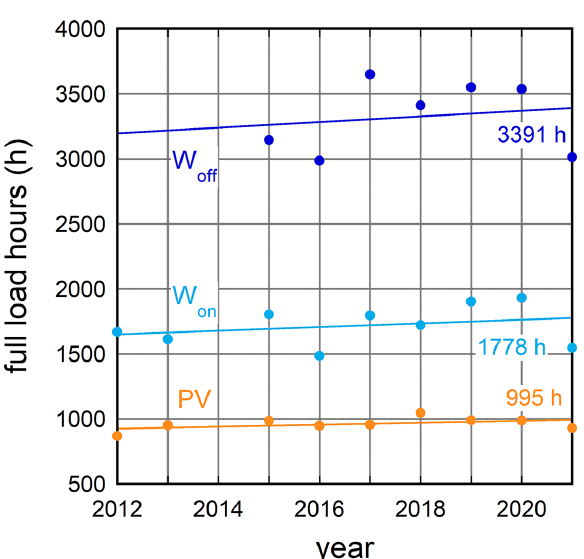
Fig. 5. – Development of full-load hours from 2012 (in case of offshore wind, W off , from 2015) to 2021 for the three iRE technologies, onshore, W on , offshore wind, W off , and photovoltaic power, PV. The lines are linear fits to the data. The numbers on the right side represent the flh -values of 2021 as obtained from the